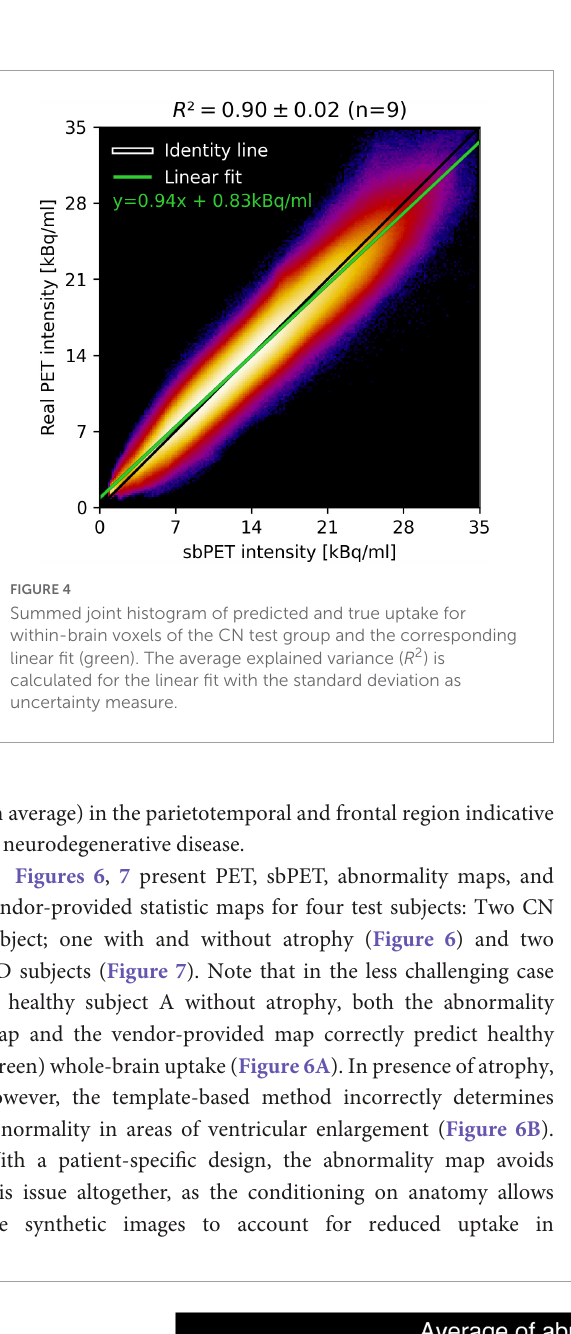
Frontiers in Neuroscience